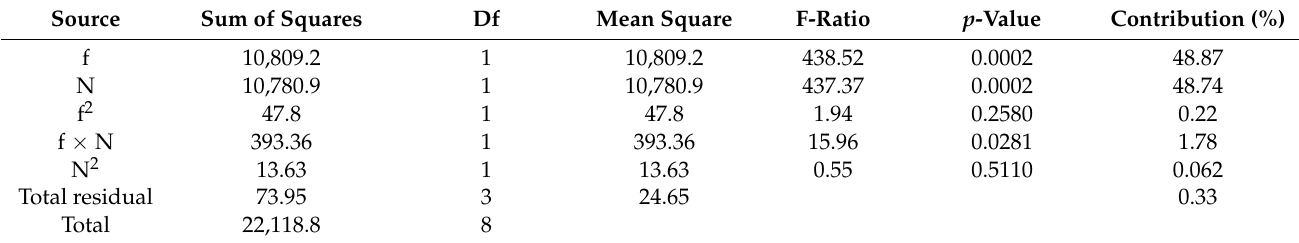
Table 5. Analysis of variance for Fz_PA66-GF30.